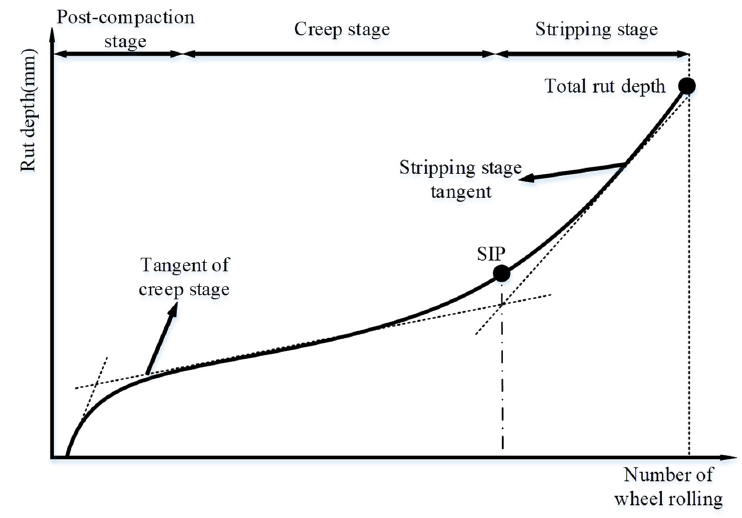
Figure 16. Schematic diagram of a conventional HWTT curve.